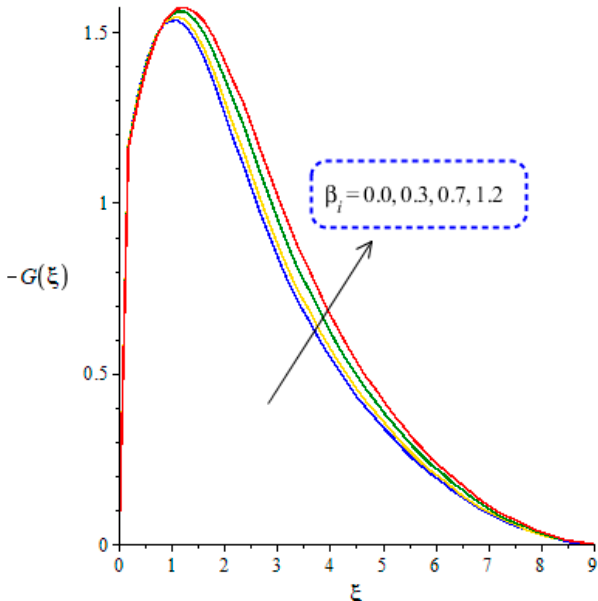
Figure 8. Variation role of 𝐹′(𝜉) versus 𝐹 (cid:3045) when 𝑚 = 0.01, 𝑊𝑒 = 5, Ω = 2.0,𝑀 (cid:2870) = 0.5,𝛽 (cid:3036) = 0.3, 𝜖 = Figure 8. Variationroleof F F r = 2.7, Pr = 204, Ec = 0.14, ϕ 2 = 0.0075, ϕ 1 = 0.002, ϕ 3 = 0.005.